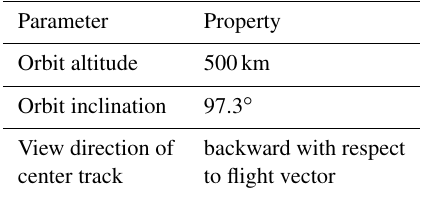
Table 1. Orbit parameters used for the simulated observations